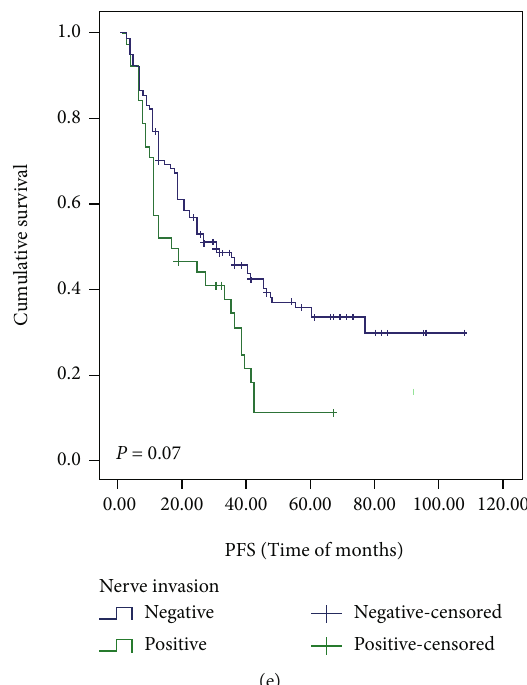
Figure 3: PFS analysis of patients ’ clinicopathological parameters with ESCC using the Kaplan – Meier method. Notes: PFS according to (a) tumor size ( P = 0 : 04 ), (b) degree of di ff erentiation ( P = 0 : 01 ), (c) lymph node metastasis ( P = 0 : 001 ), (d) AJCC stage ( P = 0 : 02 ), and (e) nerve invasion ( P = 0 : 007 ). Abbreviations: OS: overall survival; PFS: progression-free survival; ESCC: esophageal squamous cell